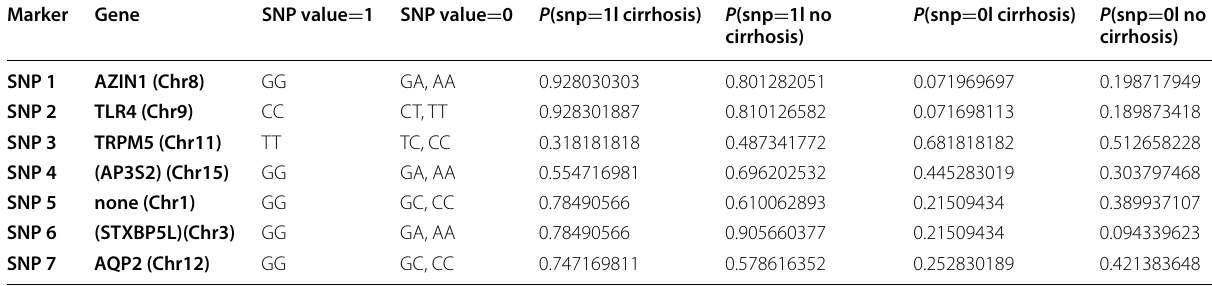
Table 3 CRS algorithm deduced by Huang et al. [20]